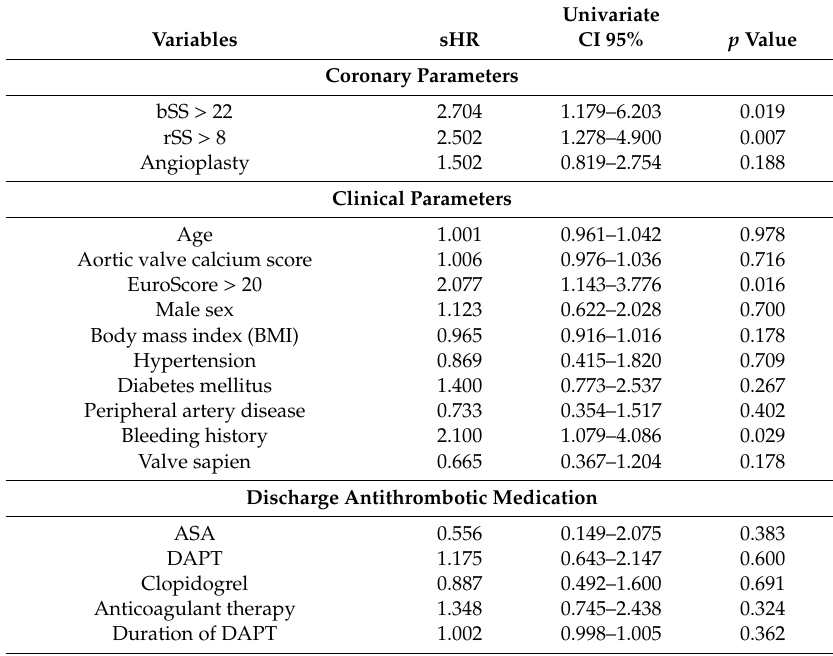
Table 5. Predictors of late major / life-threatening bleeding